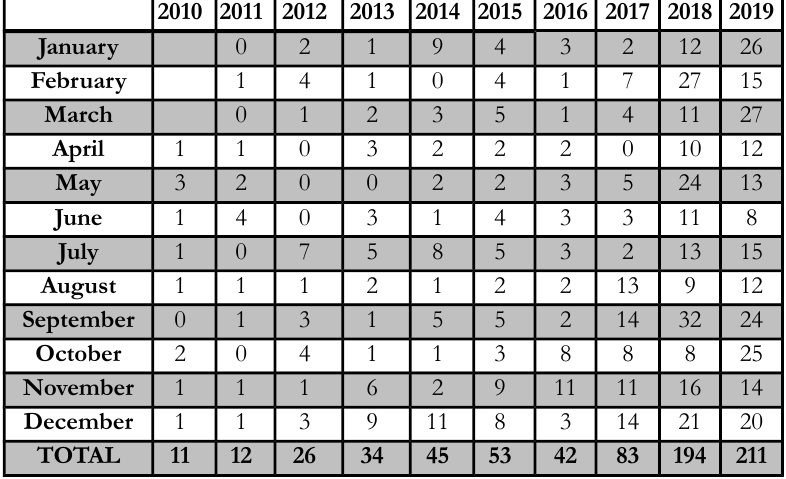
Table 1. Article submissions evolution from 2010 to 2019